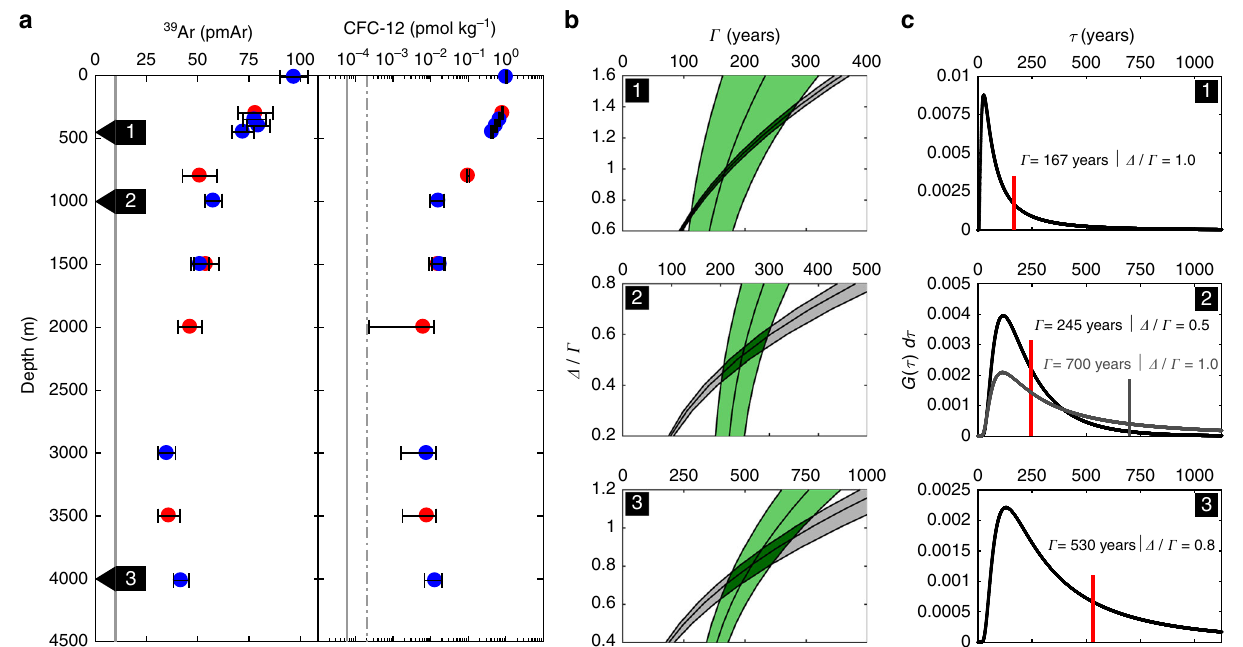
Fig. 2 Constraining inverse Gaussian transit time distributions (IG-TTDs). a shows the 39 Ar/Ar ratio pro fi les on a linear and the CFC-12 concentration pro fi les on a logarithmic scale: red markers for pro fi le #82 and blue markers for the combined pro fi le #44/#55. The indicated uncertainties for 39 Ar are given by the counting statistics, and for CFC-12 due to the on-board system performance and the known systematic uncertainties. The solid and dashed grey vertical lines indicate the limits of detection and quanti fi cation, respectively. b illustrates how 39 Ar (light green) and CFC-12 (grey) data constrain possible parameter combinations ( Γ , Δ / Γ ) of the IG-TTD given by their intersecting dark green area. c shows the corresponding distributions. For comparison we added in the middle panel the distribution obtained using only CFC-12 data with the commonly assumed Δ / Γ unity